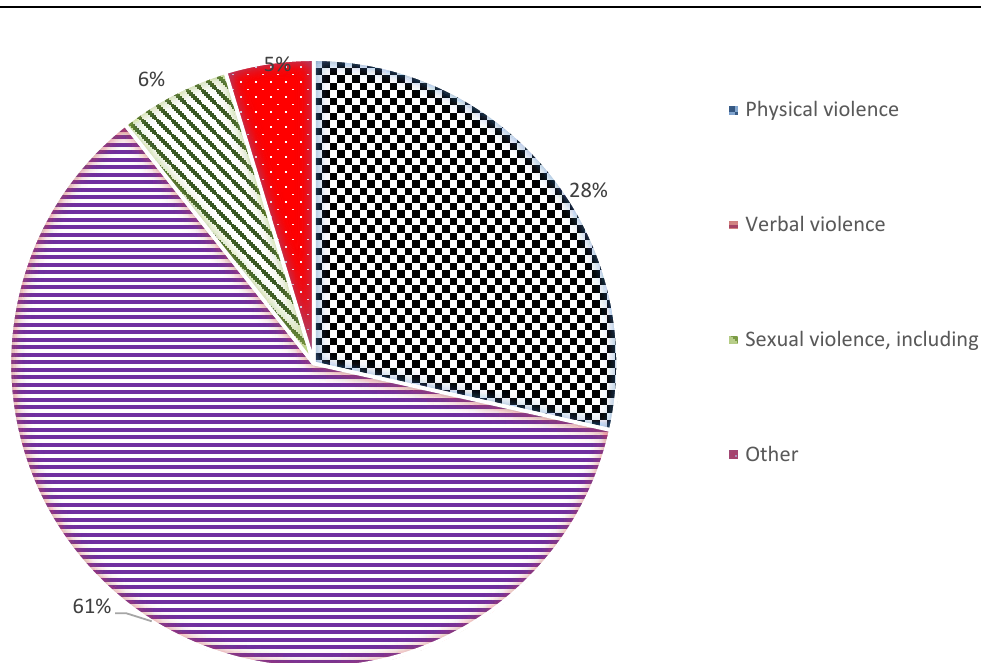
Figure 1. Type of Intimate Partners’ Violence experienced during the COVID-19 lockdown. Table 3. Type of Intimate Partners’ Violence reported by women, by province.